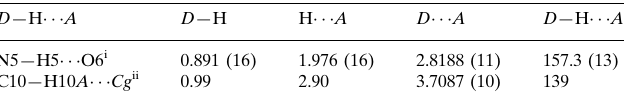
Hydrogen-bond geometry (A˚ , (cid:1)